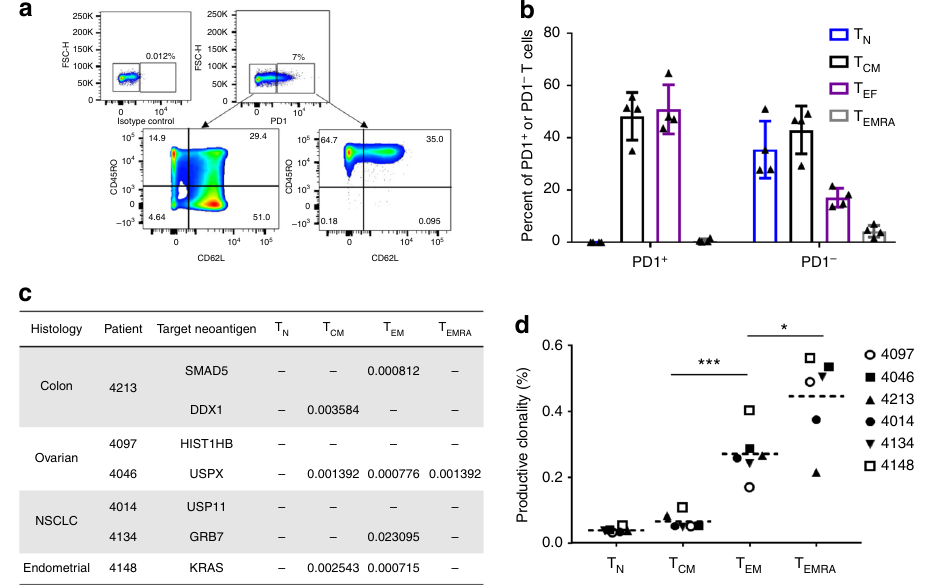
Fig. 1 Identi fi cation of neoantigen-speci fi c T cells in PBMC of epithelial cancer patients. a A representative data from one of four patients showing the gating strategy used for the phenotypic analysis of PD-1-positive (PD-1 + ) peripheral T cells. b PBMC isolated from four epithelial cancer patients were thawed, rested overnight in a cytokine-free T-cell medium and stained with antibodies against CD3, CD45RO, CD62L, and PD-1. PD-1 + and PD-1-negative (PD-1 − ) cells were analyzed for the surface expression of the T-cell memory markers, CD45RO and CD62L. Error bars indicate the mean standard deviation between all four patients samples. c PBMC isolated from six epithelial cancer patients were thawed, rested overnight in a cytokine-free T-cell medium and stained with antibodies against CD3, CD45RO, CD62L, CCR7, and CD45RA. Cells were sorted based on their memory subset, washed once with PBS, frozen at − 80 °C and send for TCR-V β sequencing. Numbers represent the percent of speci fi c TCR-V β sequence in each T-cell population. A minus sign ( − ) was used If no sequence was identi fi ed. d Analysis of the productive clonality of TCR-V β sequences of each T-cell population isolated in c . (Paired t -test, *** P < 0.001, * P < 0.05) dashed line,